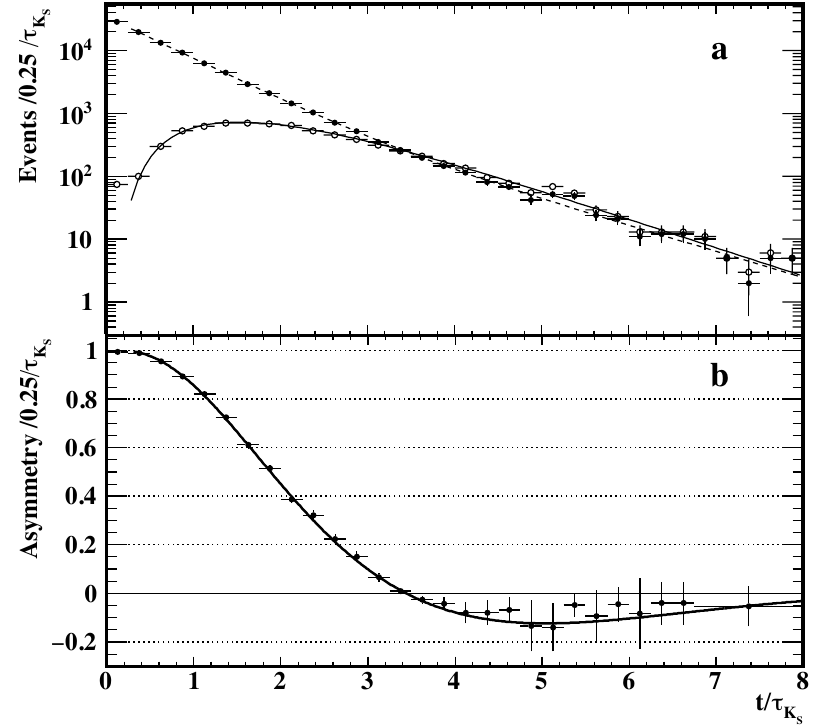
Figure 6 . (a) \Toy" MC generated time-dependent decay rates. The histogram with (cid:12)lled black circles corresponds to \right sign" and with open circles correspond to the \wrong sign" decay rates. The solid and dashed lines correspond to the result of the simultaneous (cid:12)t. (b) The resulting decay rate asymmetry with the (cid:12)t result superimposed.